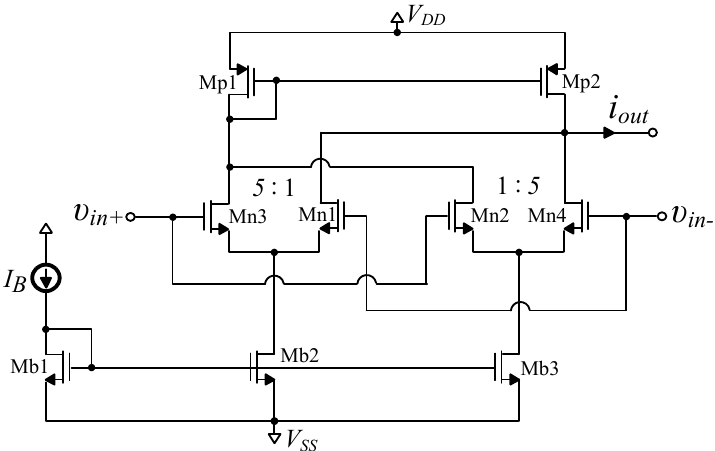
Figure 5. MOS circuitry of a high-linearity OTA, as employed in